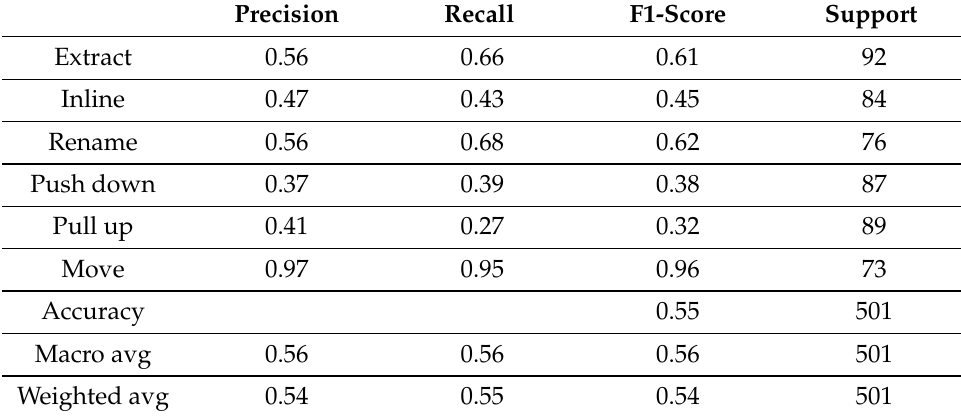
Table 6. Metrics per